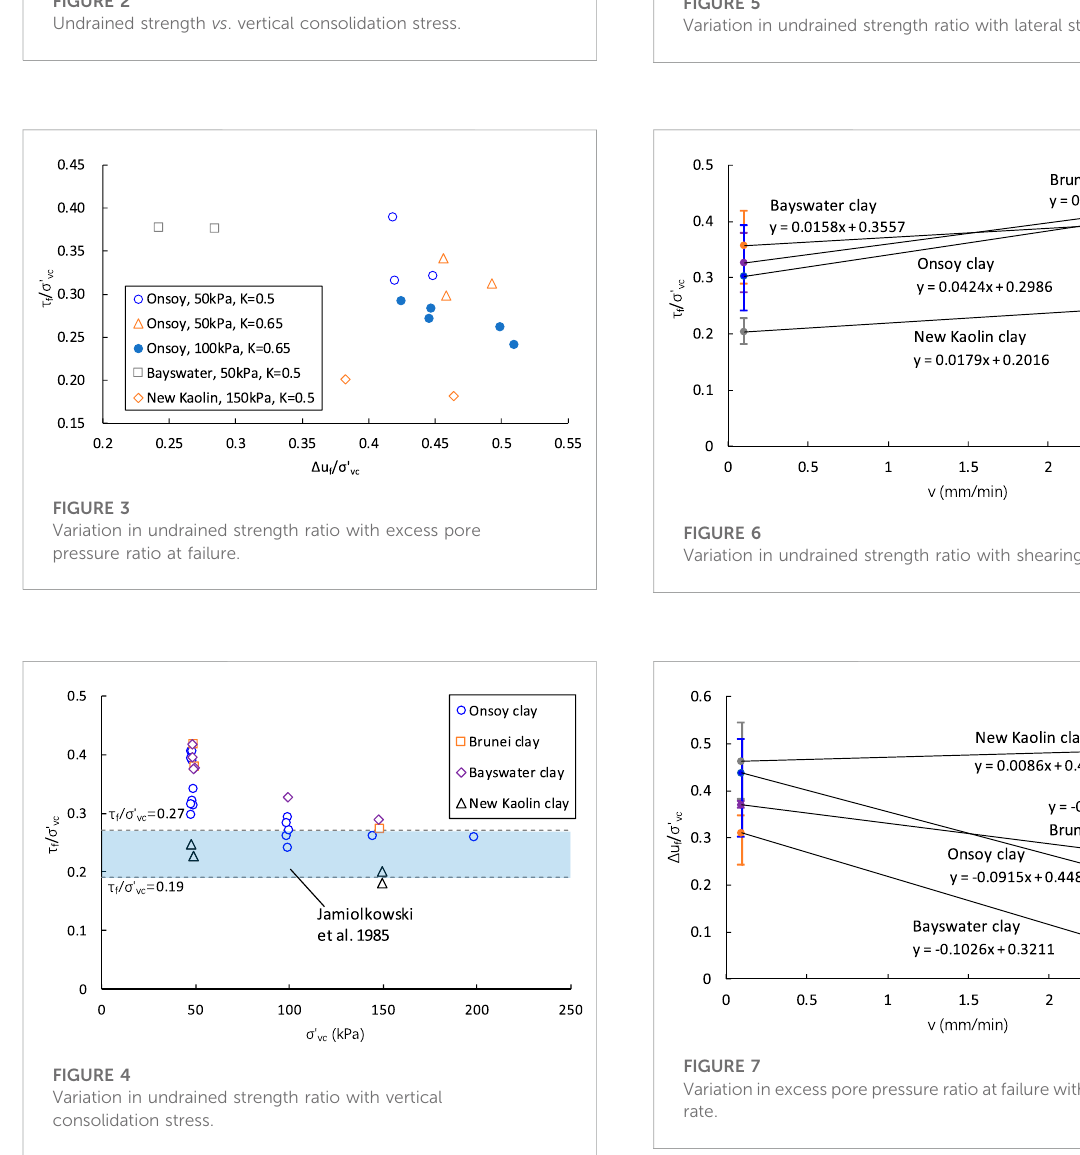
FIGURE 2 Undrained strength vs . vertical consolidation stress.